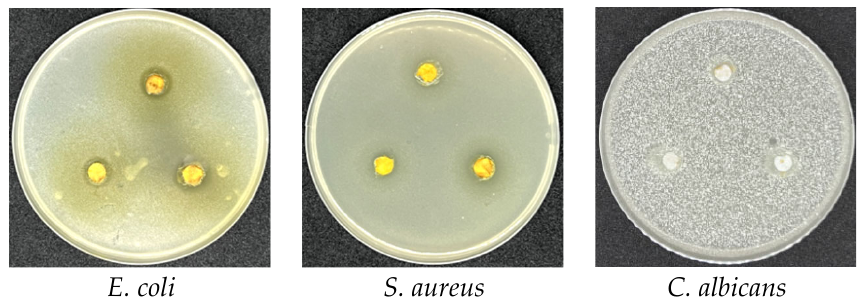
Figure 10. Antimicrobial e ff ect of SPEO-Ms on E. coli , S. aureus , and C. albicans .